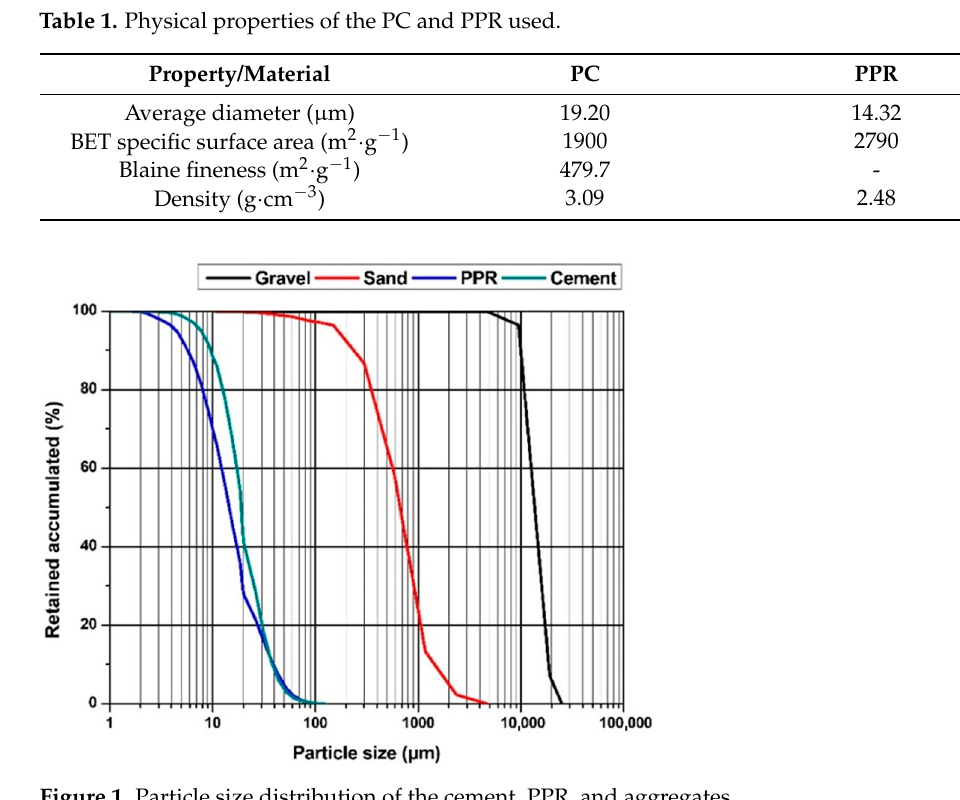
Figure 1. Particle size distribution of the cement, PPR, and aggregates. Table 1. Physical properties of the PC and PPR used.